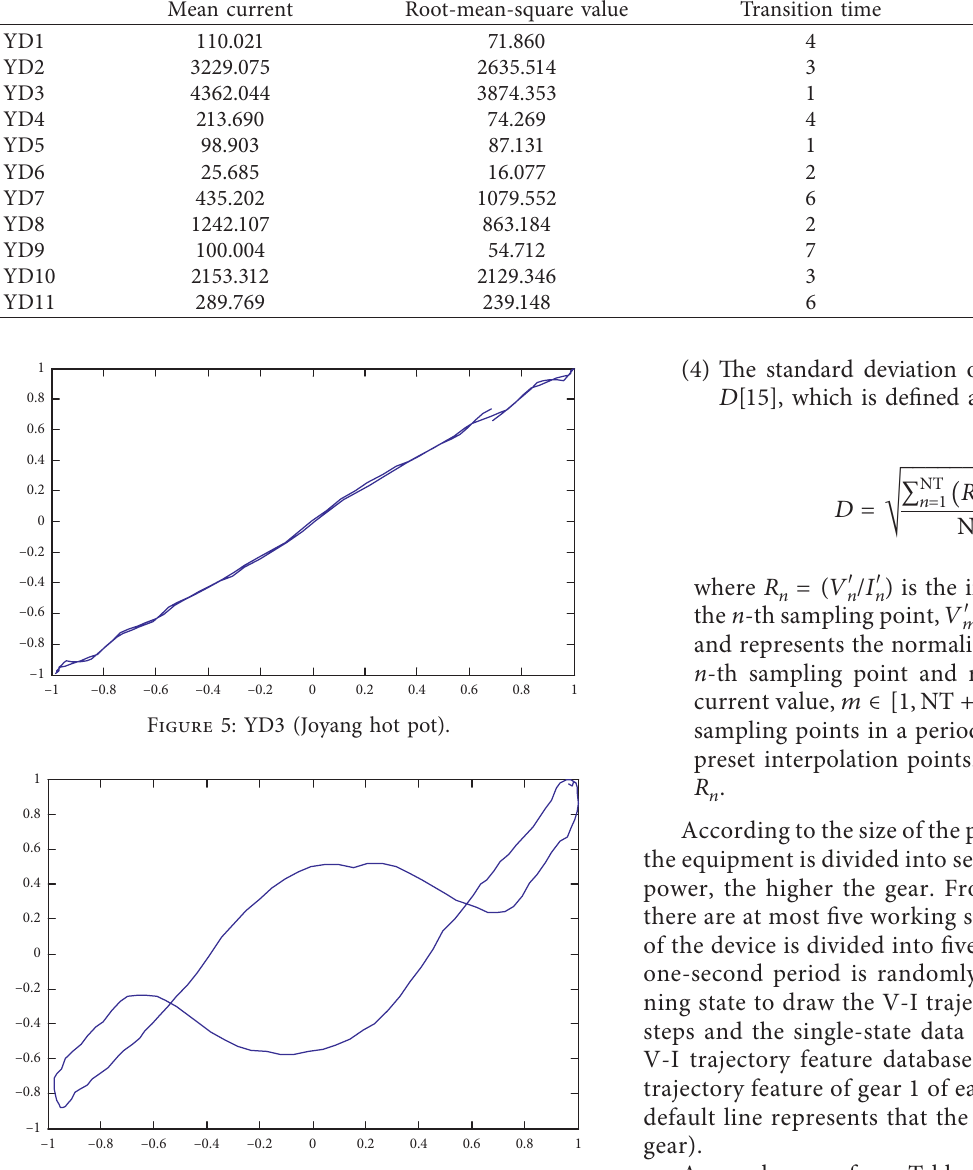
Figure 6: YD2 (Midea